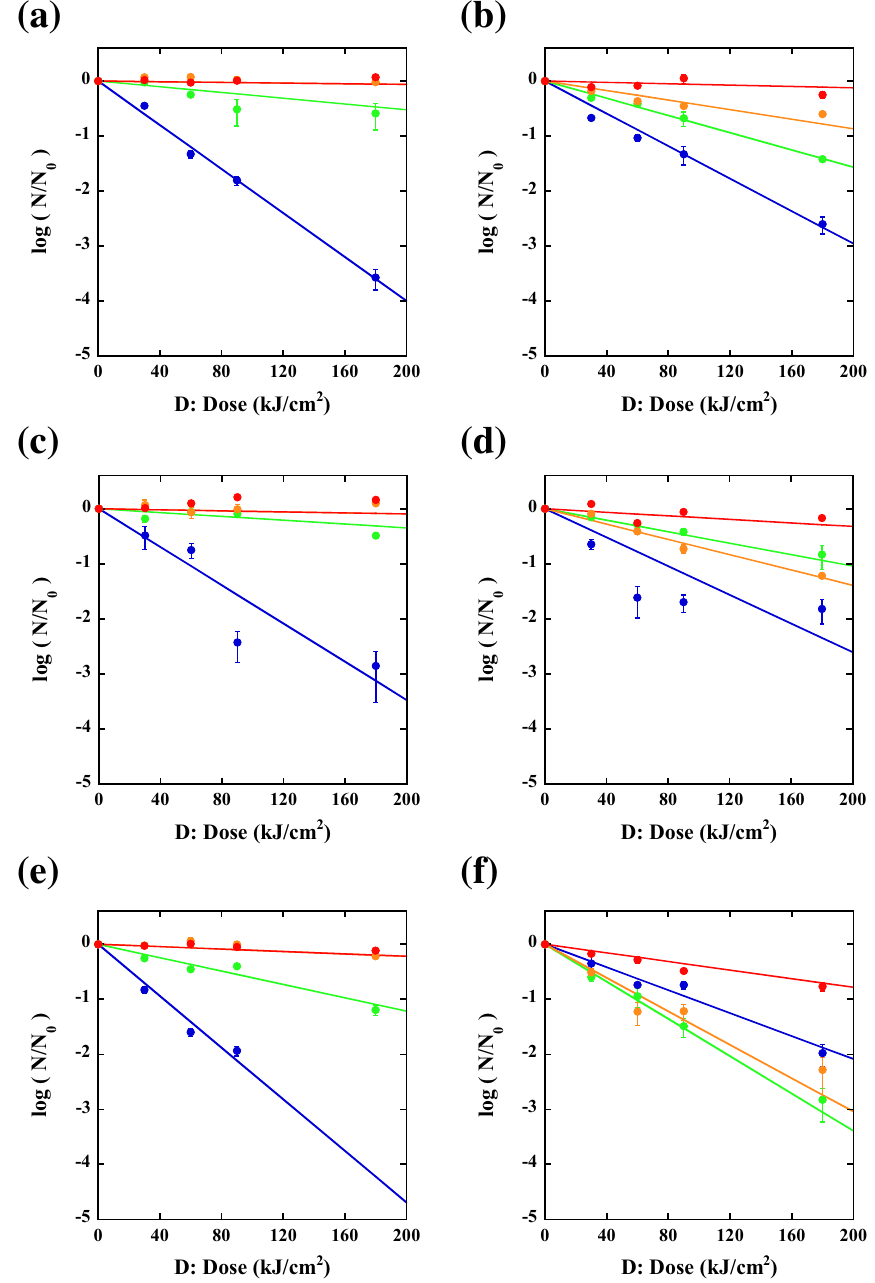
Figure 5. Dose (D) response of stained or unstained E. coli inactivated by tunable pulsed laser treatment. The blue circles are the inactivation rates with 420 nm treatments, the green circles are the inactivation rates with 500 nm treatments, the orange circles are the inactivation rates with 600 nm treatments, and the red circles are the inactivation rates with 650 nm treatments. ( a ) Dose response of unstained E. coli O1, ( b ) dose response of crystal violet-stained E. coli O1, ( c ) dose response of unstained E. coli ATCC 8739, ( d ) dose response of crystal violet-stained E. coli ATCC 8739, ( e ) dose response of unstained E. coli DH5α, and ( f ) dose response of crystal violet-stained E. coli DH5α. The dose-based inactivation rate constants Γ (cm 2 /kJ) of stained samples (solid lines of b , d , f ) were theoretically obtained based on those of unstained results (solid lines of a , c , e ). The experimentally ( a , c , e ) and theoretically ( b , d , f ) determined values of Γ (cm 2 /kJ) are described in Table